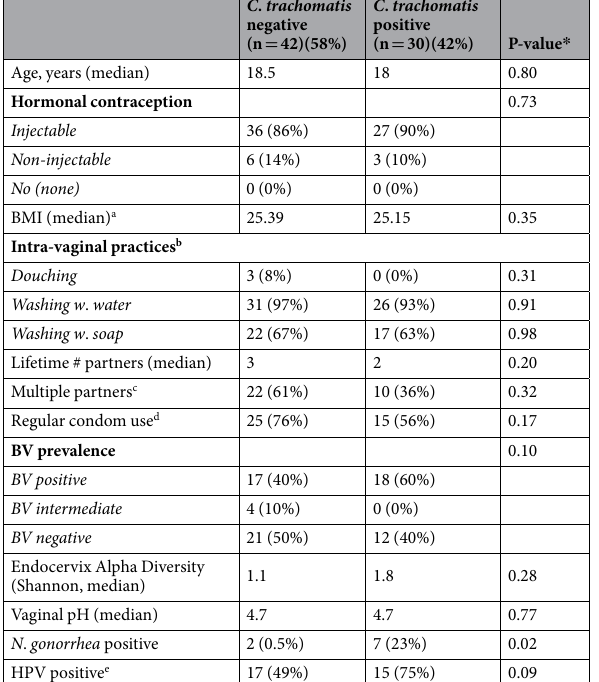
Table 1. Study population characteristics. * Chi-squared test (Fisher’s exact test when expected values < 5) for the assessment of association of frequency among groups and the Mann–Whiney U-test for comparison of medians. Unpaired t-test for alpha diversity. BV; bacterial vaginosis, STI; sexually transmitted infection, OCP; oral contraceptive pills. a participants had missing information. b 11 participants had missing information. c 15 participants had missing information. d 12 participants had missing information. e 17 participants had missing